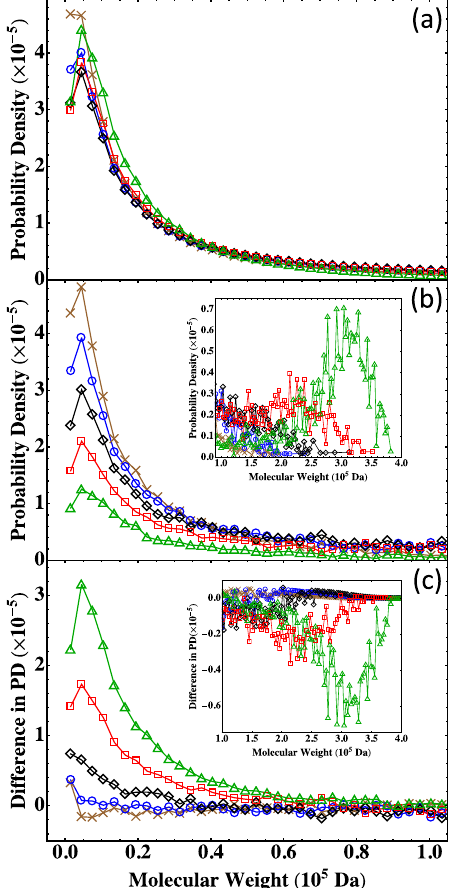
Figure 8. MWD from ( a ) the Flory-Stockmayer theory and ( b ) the MC simulations. The inset of ( b ) shows the MC results in the high molecular weight region. ( c ) Difference in the probability density (PD) from the Flory-Stockmayer theory and the MC simulations, with the inset showing data in the high molecular weight region. The results are for S 0.95 (brown crosses), S 0.96 (blue circles), S 0.97 (black diamonds), S 0.98 (red squares), and S 0.99 (green triangles). The MC results are the averages of 1000